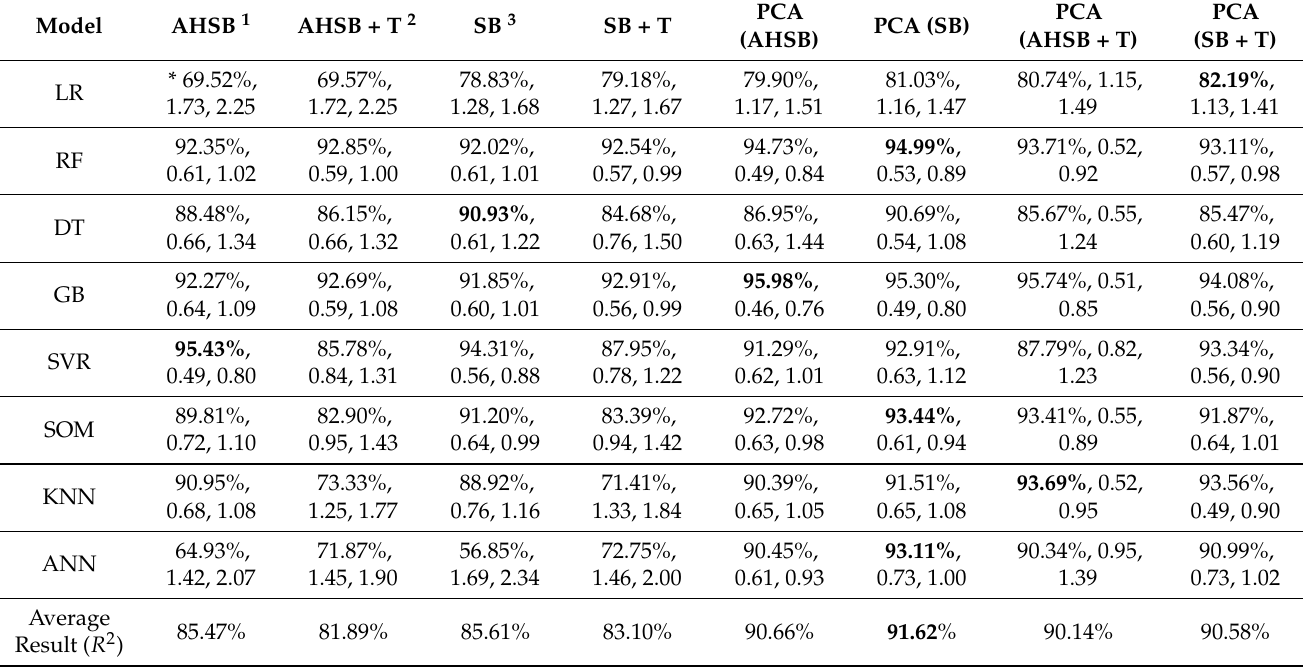
Table 2. Regression results ( R 2 , MAE , RMSE ) for different ML models in predicting soil moisture. The bold values represent the best results (in terms of R 2 ) considering different ML